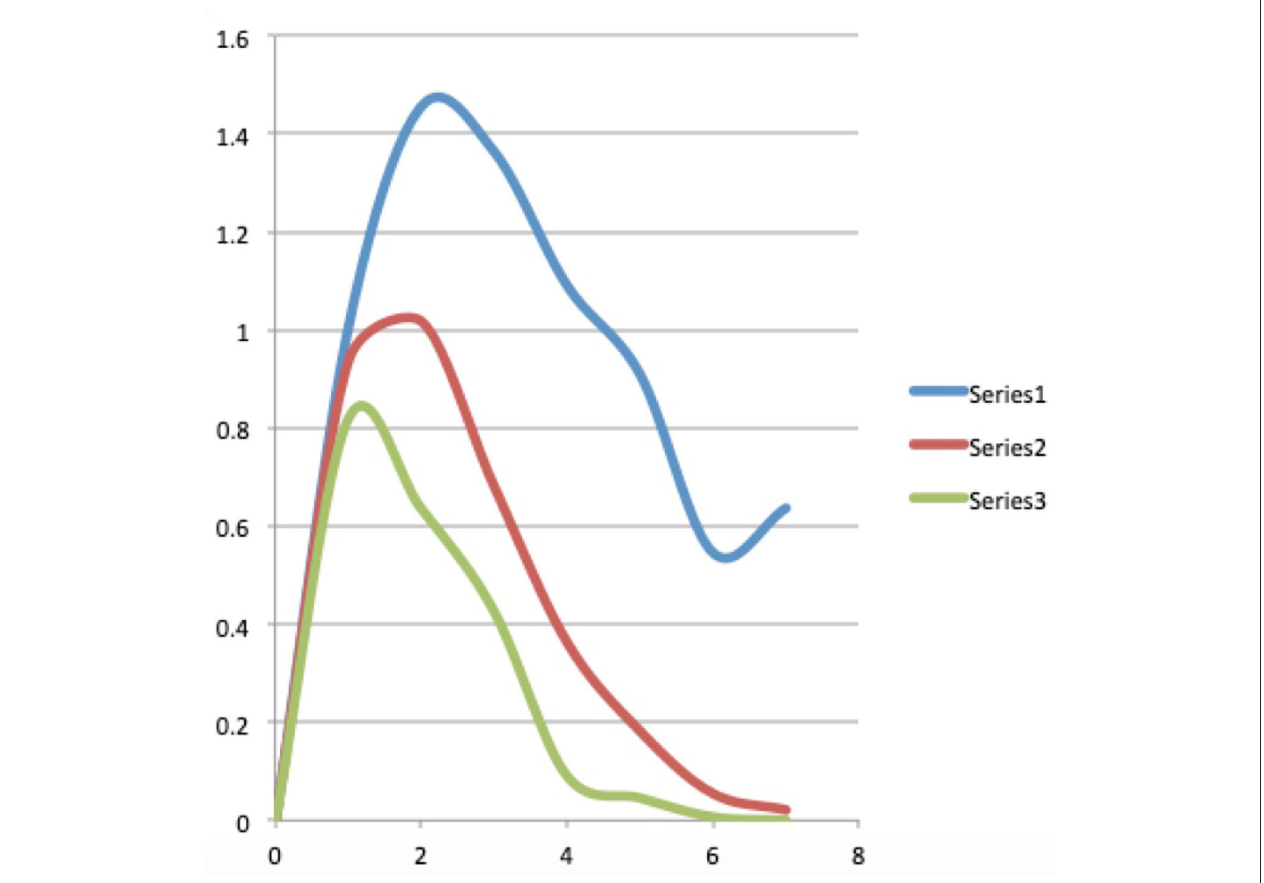
FIGURE 7 | The blue, red and green curves are the Bose-Einstein energy radiation function the Maxwell-Boltzmann energy radiation function and the Fermi-Dirac energy radiation function of the situation of four words distributed over seven energy levels with total energy equal to seven.